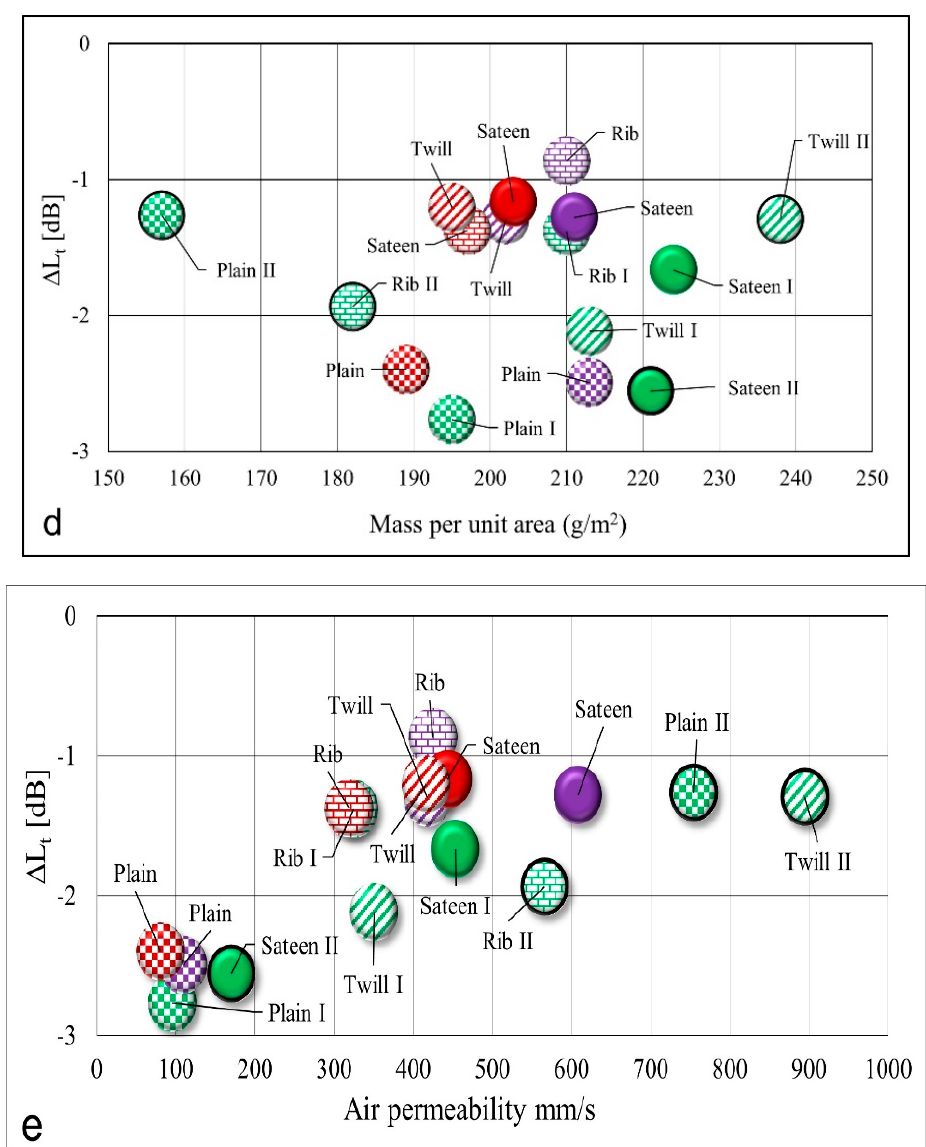
Figure 10. Overall yarn type and fabric properties comparison concerning sound level drop at 0 ° . ( a ) Illustrates the relationship between the warp density of fabrics and the total sound pressure level drop. ( b ) Presents the weft density of fabrics in relation to total sound pressure level drop. ( c ) Depicts the effect of fabric thickness on fabric total sound pressure level drop. ( d ) Illustrates the effect of fabric mass per unit area on total sound pressure level drop. ( e ) Depicts the relationship between the fabrics’ total sound pressure level drop and air permeability performances.